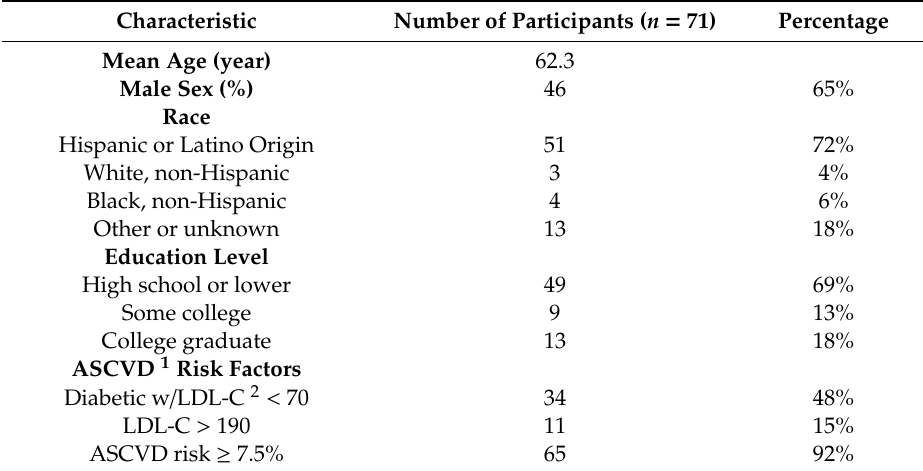
Table 1. Demographic Characteristics of